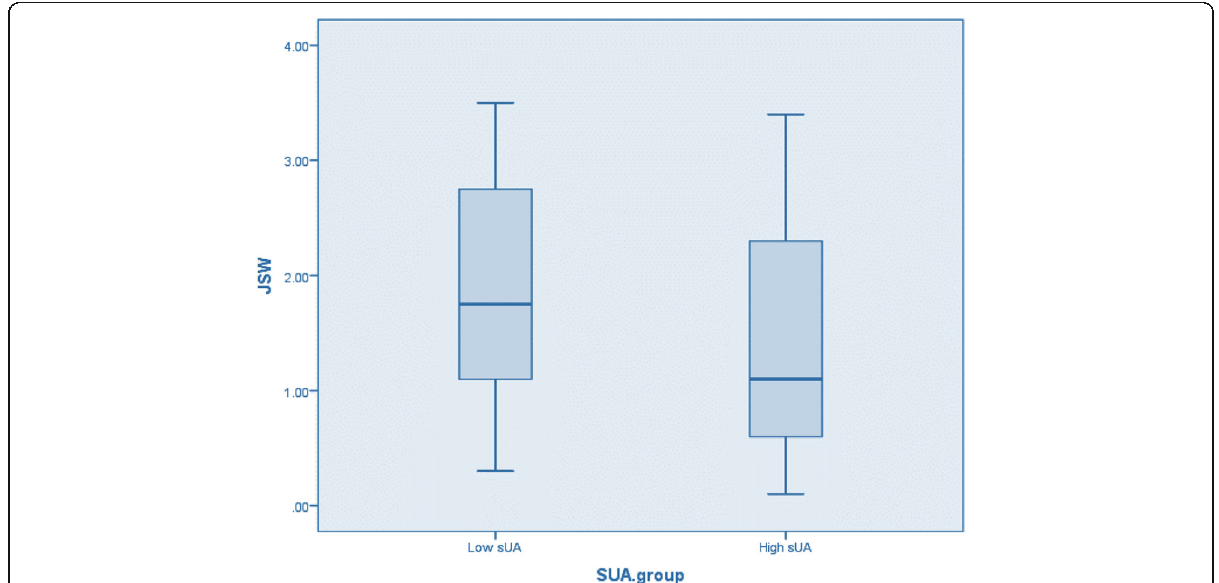
Fig. 2 Comparison of the JSW between KOA patients in L-sUA group versus H-sUA